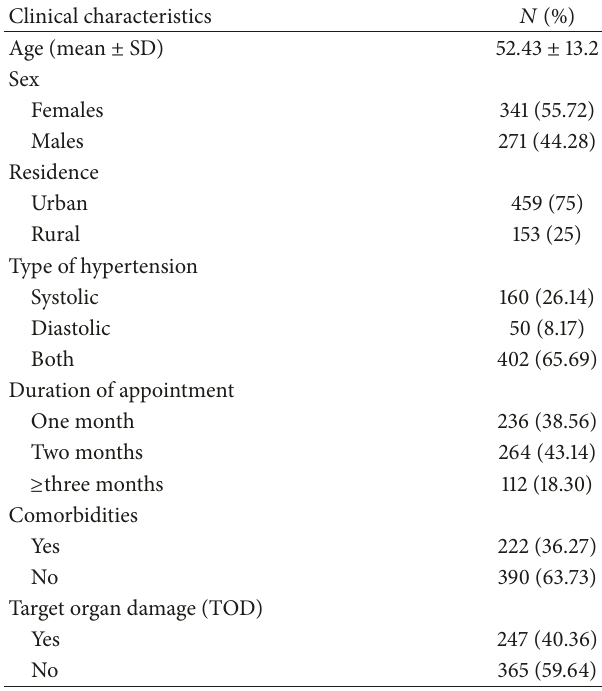
Table 1: The sociodemographic and clinical characteristics of participants ( 𝑁 = 612